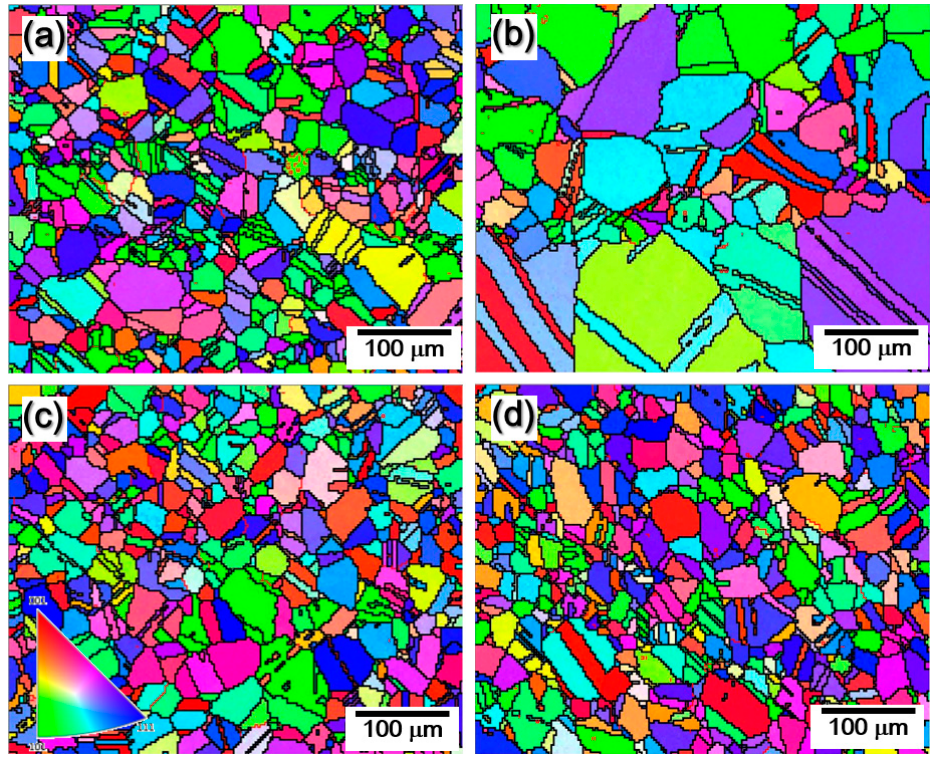
Figure 4. EBSD characterization of the Ni-based alloys before and after heat treatment: specimens ( a ) #1, ( b ) #2, ( c ) #3 and ( d ) #4.